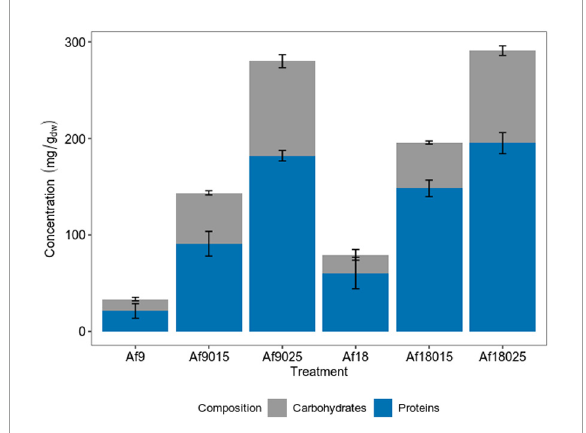
FIGURE1 Carbohydrates and protein compositions of the EPS of A. ferrooxidans cultured at different concentrations of iron and galactose. Blue color: protein; Gray color: Carbohydrates. The data correspond to the mean values of triplicates ± SD ( n =